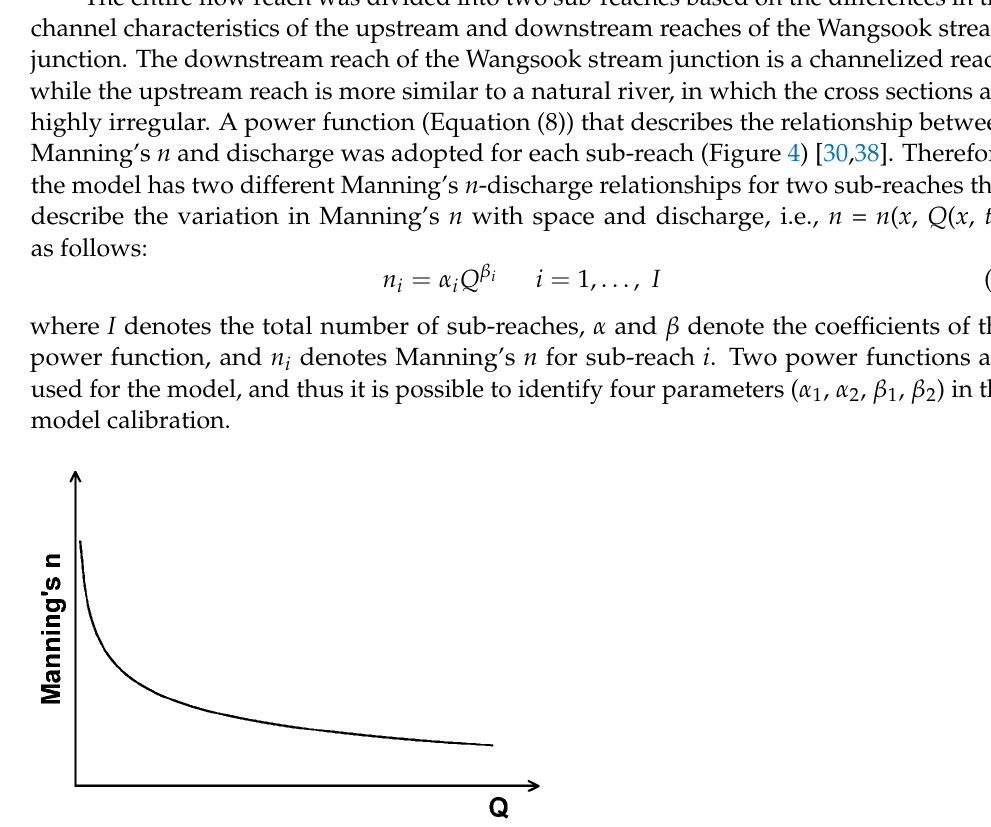
Figure 4. Functional relationship between Manning’s n and discharge: power function [30].